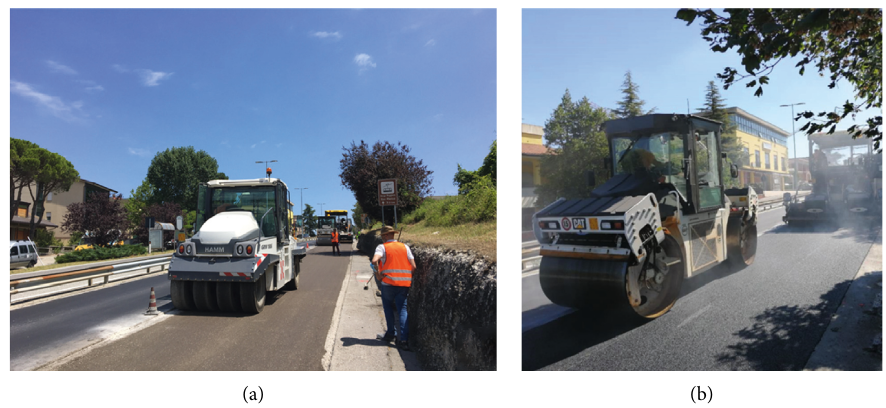
Figure 8: (a) Construction of the CRM binder layer; (b) construction of the AC wearing course.